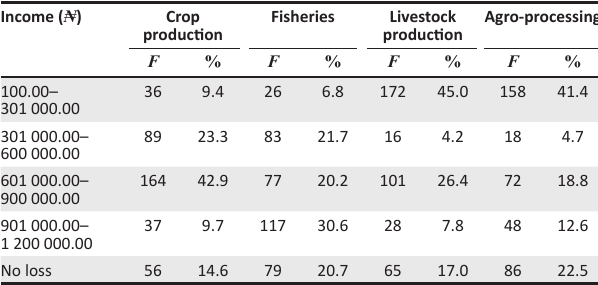
TABLE 6: Income loss in agricultural sector.